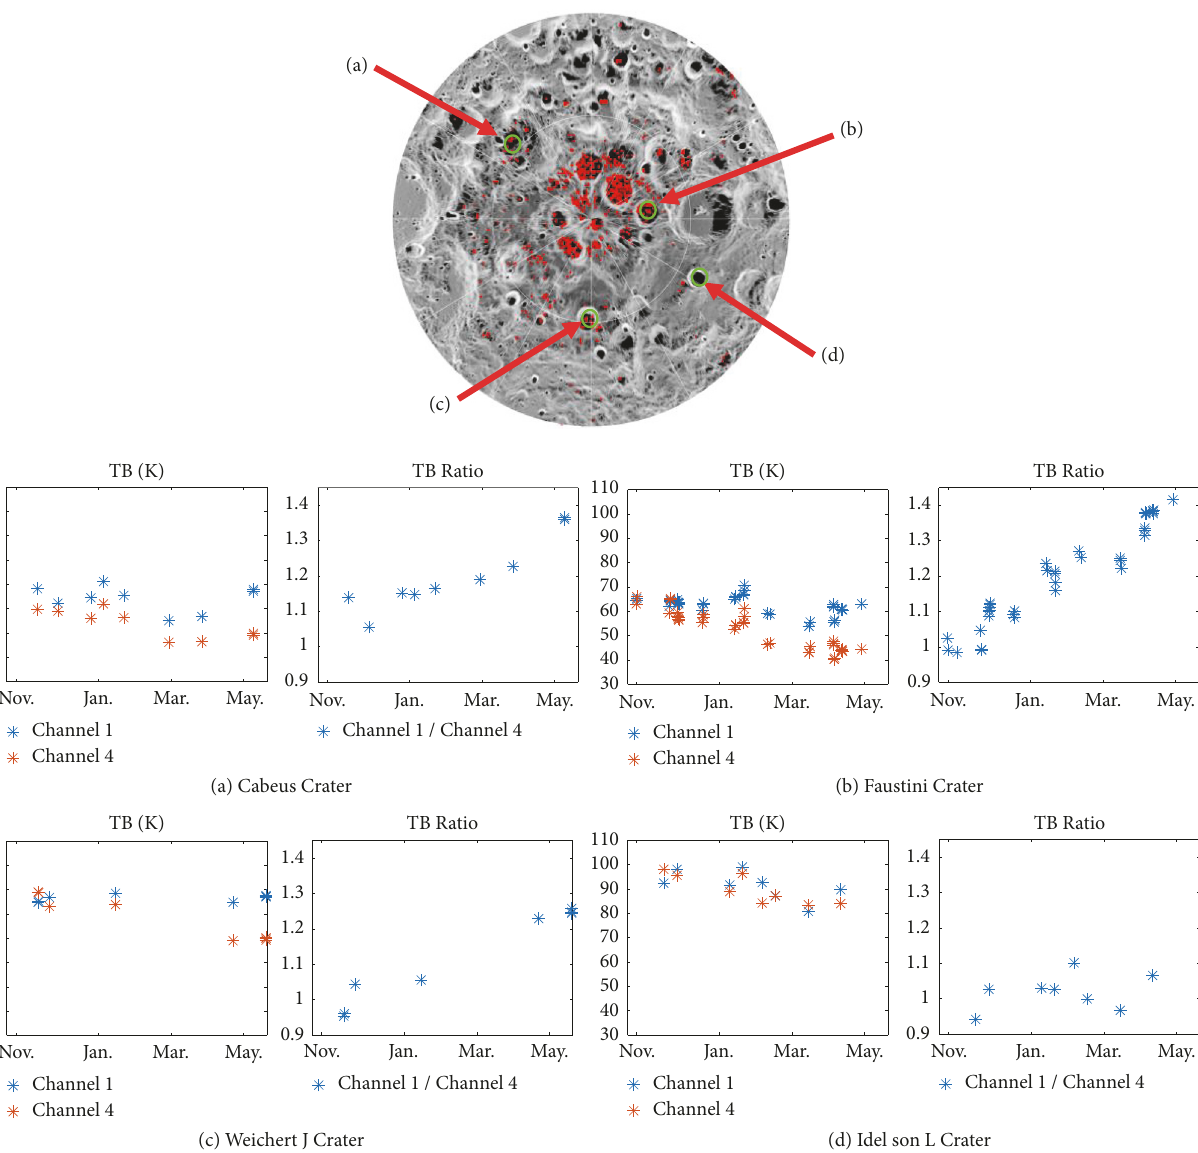
Figure 4: The TB and TBR variations during the whole observation period in (a) Cabeus Crater, (b) Faustini Crater, (c) Weichert J Crater, and (d) Idel son L Crater. The base map is the Diviner annual maximum temperature map that varies from 30 K (black) to 345 K (white) in the Polar Regions (https://ode.rsl.wustl.edu/moon/indexDatasets.aspx). The red dots in the base map present the water ice distribution in the polar regions constrained by M 3 , LOLA, and Diviner [12]. The green circle in the base map shows the regions we